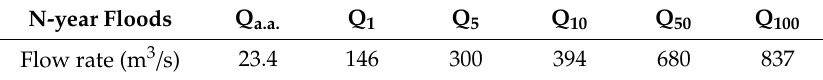
Table 1. The flow rates for N-year floods in the Otava River reach [39]. N-year